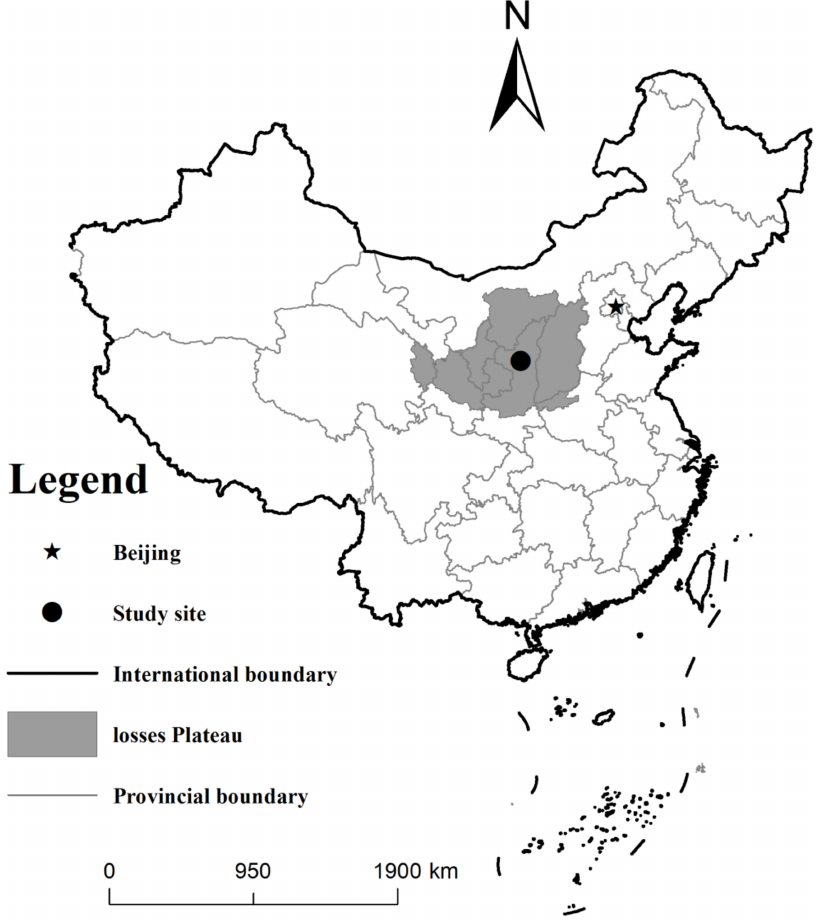
Figure 1. The locations of study sites in Ansai County, Shanxi Province,